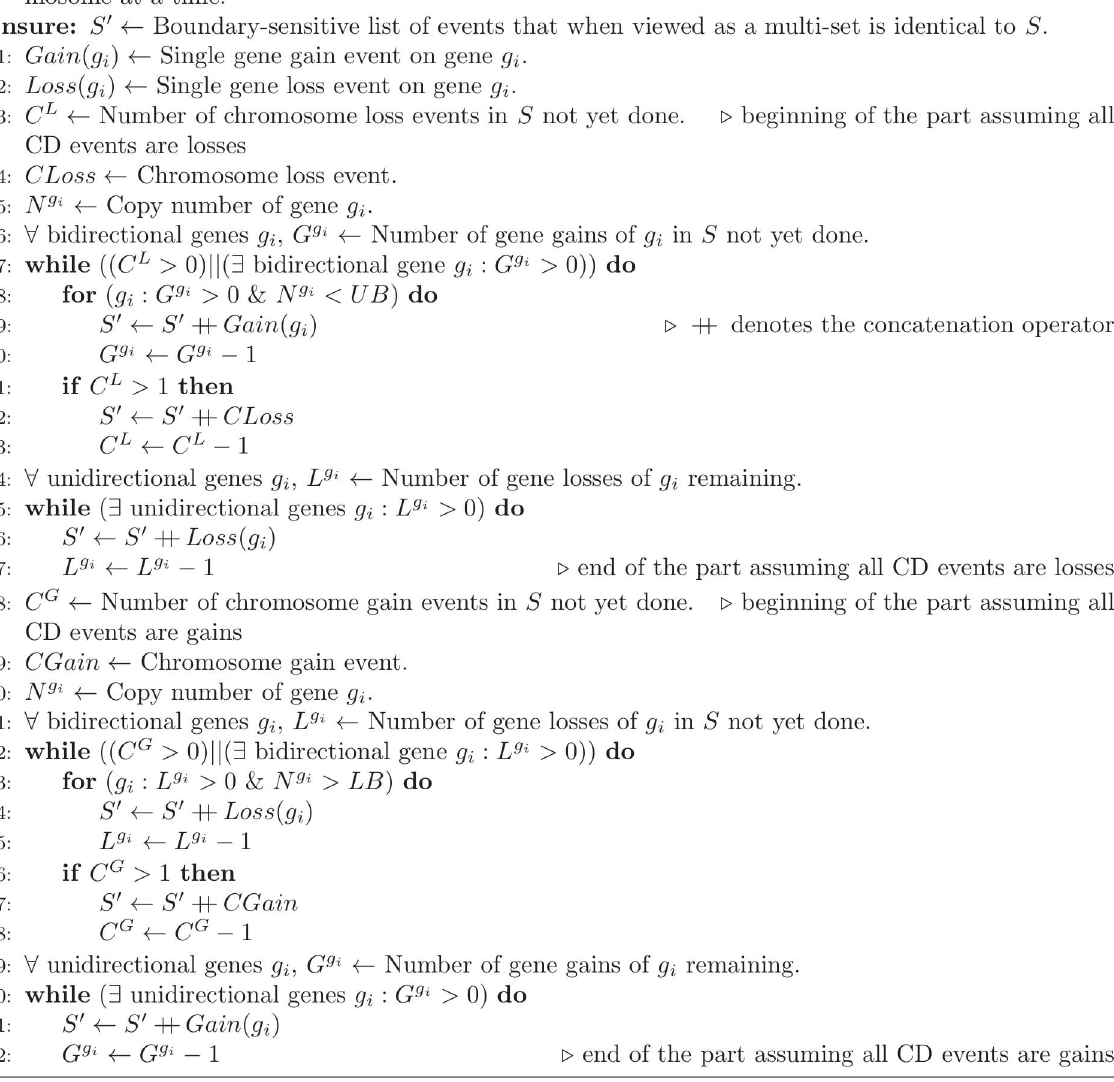
Figure 10. Algorithm 1 pseudocode. Algorithm 1 converts a set of boundary-insensitive events to boundary-sensitive events; lines 3–17 are used for chromosomes on which all CD events are losses and lines 18–32 are used for chromosomes on which all CD events are gains.